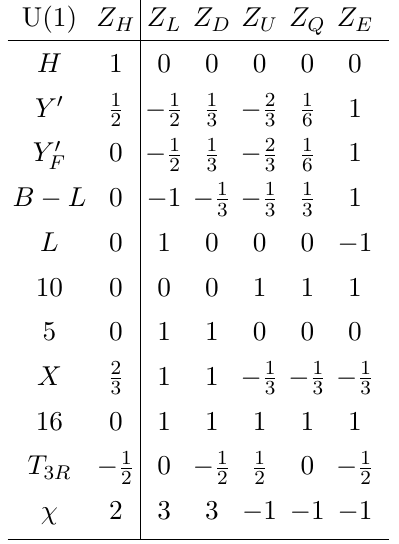
Figure 5. Minimal Z 0 with charges Z i = ( B − L ) i cos θ + Y i sin θ favoured by the global